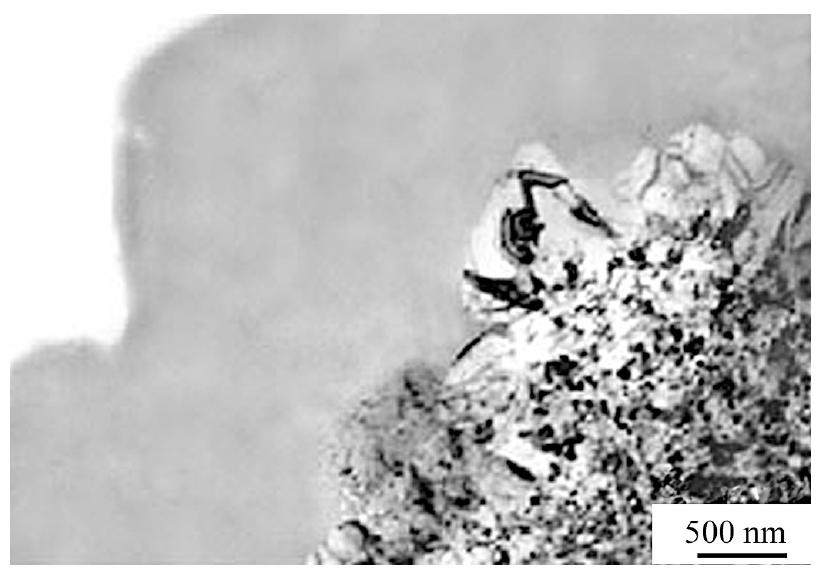
Figure 21. Microstructure of pre-annealed Fe83B10P7 sample partially crystallized in situ [reproduced from Physics of The Solid State 1991, 33, 2527 with permission from Pleiadis Publishing, 2020] [155].